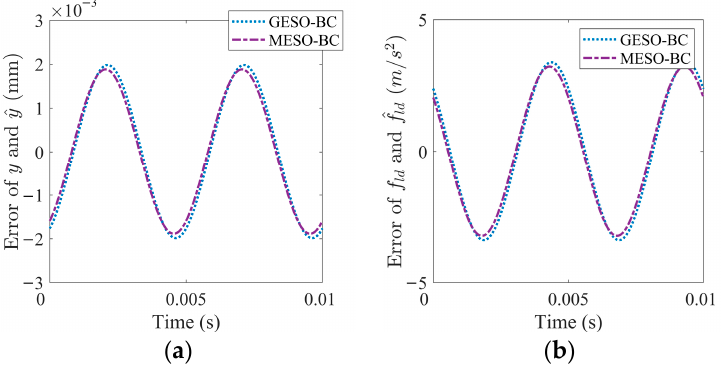
Figure 9. ESO estimation errors: ( a ) Estimation error of 𝑦 and 𝑦(cid:3548) ; ( b ) estimation error of 𝑓 (cid:3039)(cid:3031) and 𝑓(cid:4632) (cid:3039)(cid:3031) .